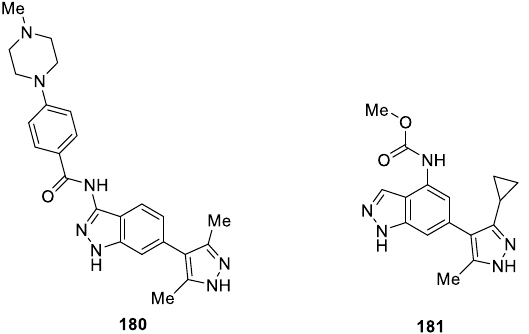
Figure 59. Chemical structures of 4,6-disubstituted indazole analogues 180 and 181 .